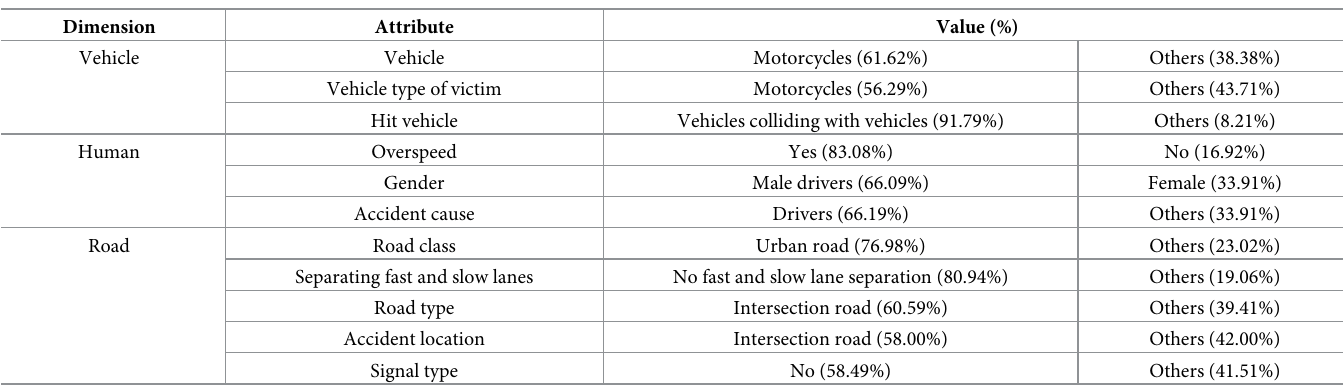
Table 12. Road accident factors and attribute value more than